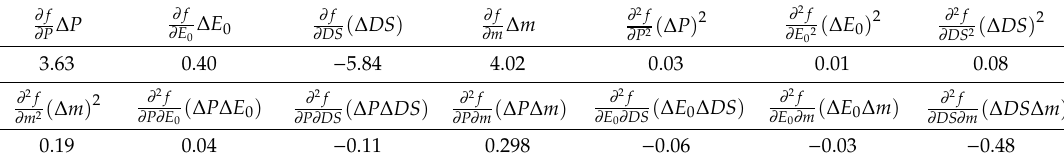
Table 8. Partial derivatives of runo ff variables in the Lhasa River during the dry